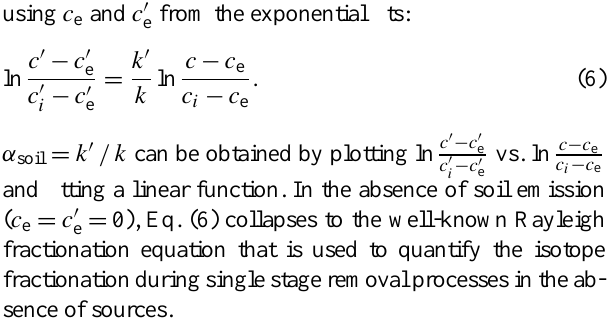
0 Figure 5. Results of the flask sampling model with the fol- lowing parameters: k = 0.1min − 1 , P = 10ppbmin − 1 and c 1 ( t = 0) = 530ppb. The figure shows the evolution of H 2 mole fraction in the chamber (green curve), in flask 2 (blue curve), flask 3 (red curve) and flask 4 (magenta curve) as a function of time and what would be expected for a chamber without flasks (black curve). Flask 1 was closed before closing the chamber (at time 0 when all volumes con- tained the same